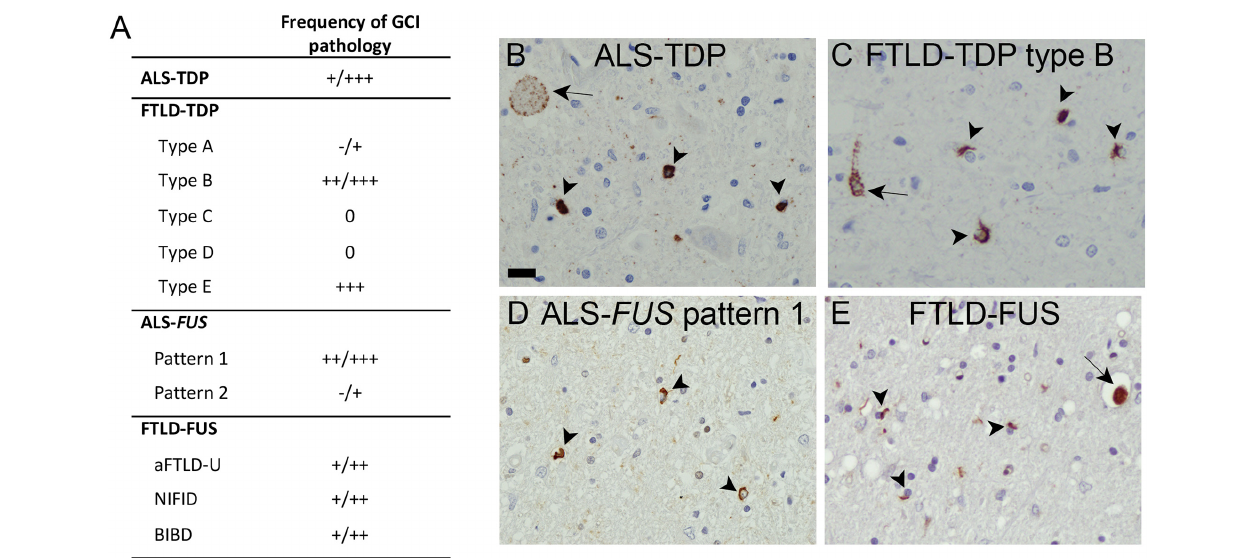
FIGURE 1 | Oligodendroglial pathology in TDP-43 and FUS proteinopathies. (A) Glial cytoplasmic inclusions (GCI) are a characteristic feature with presence in variable amounts in affected brain regions in ALS—TDP, in subtypes of FTLD—TDP (particularly types B,E), subtypes of ALS— FUS (particularly in pattern 1 associated with adult onset and longer disease duration), and all distinct entities of FTLD—FUS, including aFTLD-U, basophilic inclusion body disease, and neuronal intermediate filament inclusion disease. Semiquantitative scores: 0, absent;+, rare;++, moderate; +++, abundant. (B–E) Immunohistochemistry of human postmortem tissues with pTDP-43 S409/410 antibody (Neumann et al., 2009a) demonstrating numerous GCI (arrowheads) in spinal cord of ALS—TDP case (B) and frontal cortex of FTLD—TDP type B case (C) , and FUS (Proteintech) immunohistochemistry demonstrating GCI in spinal cord of ALS- FUS case with pattern 1 pathology (D) and basal ganglia of FTLD—FUS (basophilic inclusion body disease) case (E) in addition to neuronal cytoplasmic inclusions (arrow). Scale bar in panel B = 20 µ